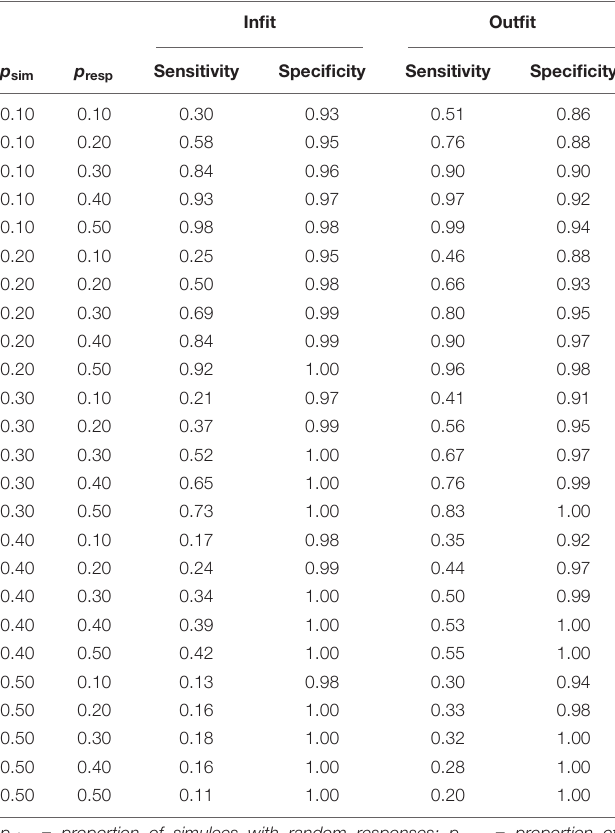
TABLE 1 | Sensitivity and specificity of infit and outfit in the tests with dichotomous items. Infit